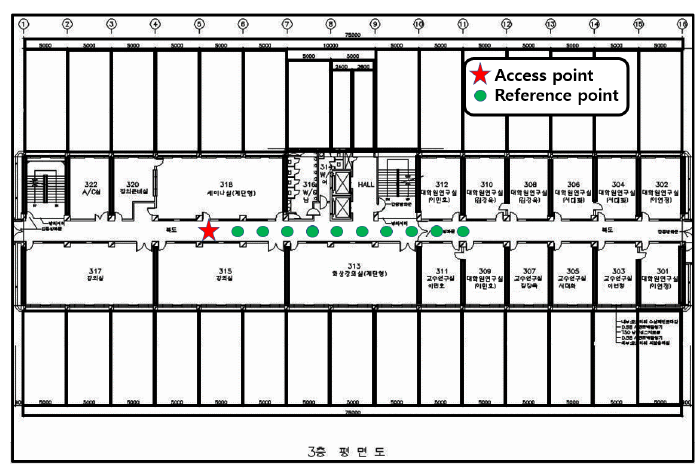
Figure 8. Schematic diagram of the indoor experiment environment at the 3rd floor of IT-1 building.